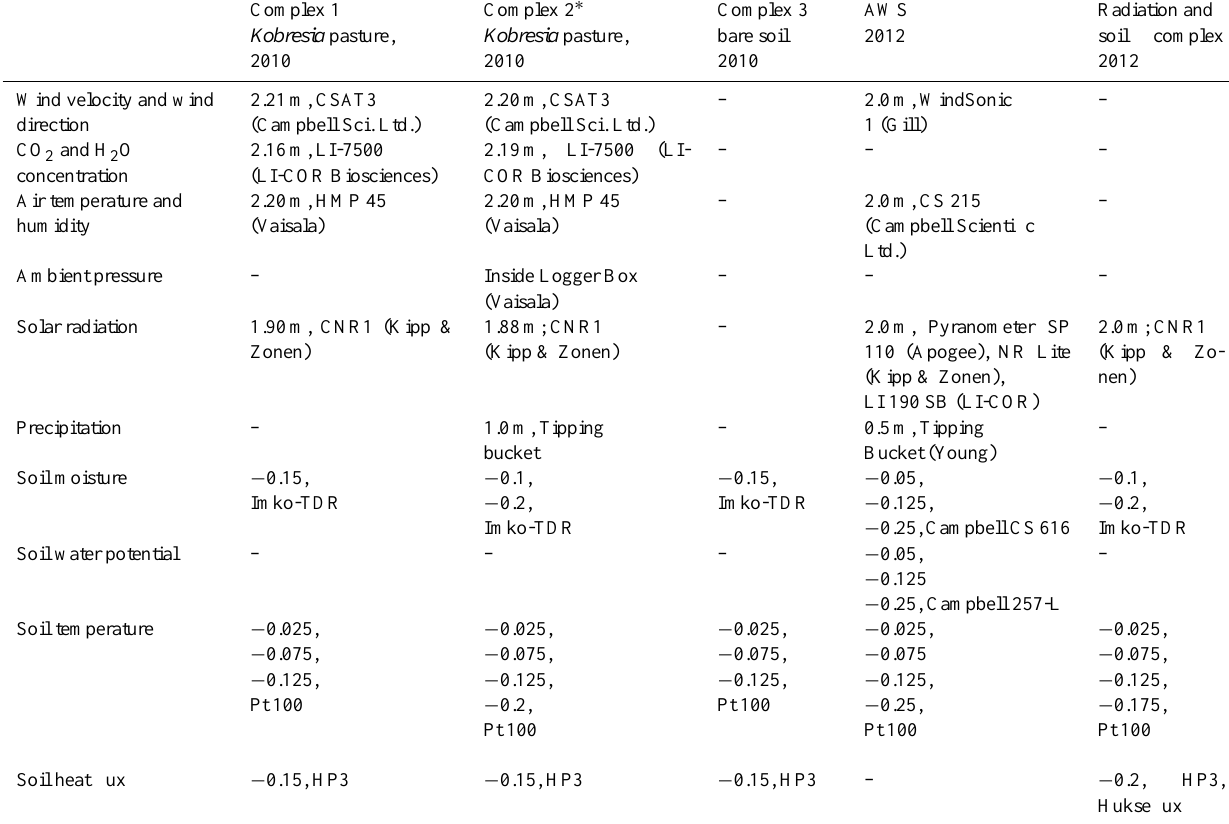
Table 3. Instrumentation of Kema site in 2010 (6 June–2 August) and 2012 (11 July–10 September, AWS: automatic weather